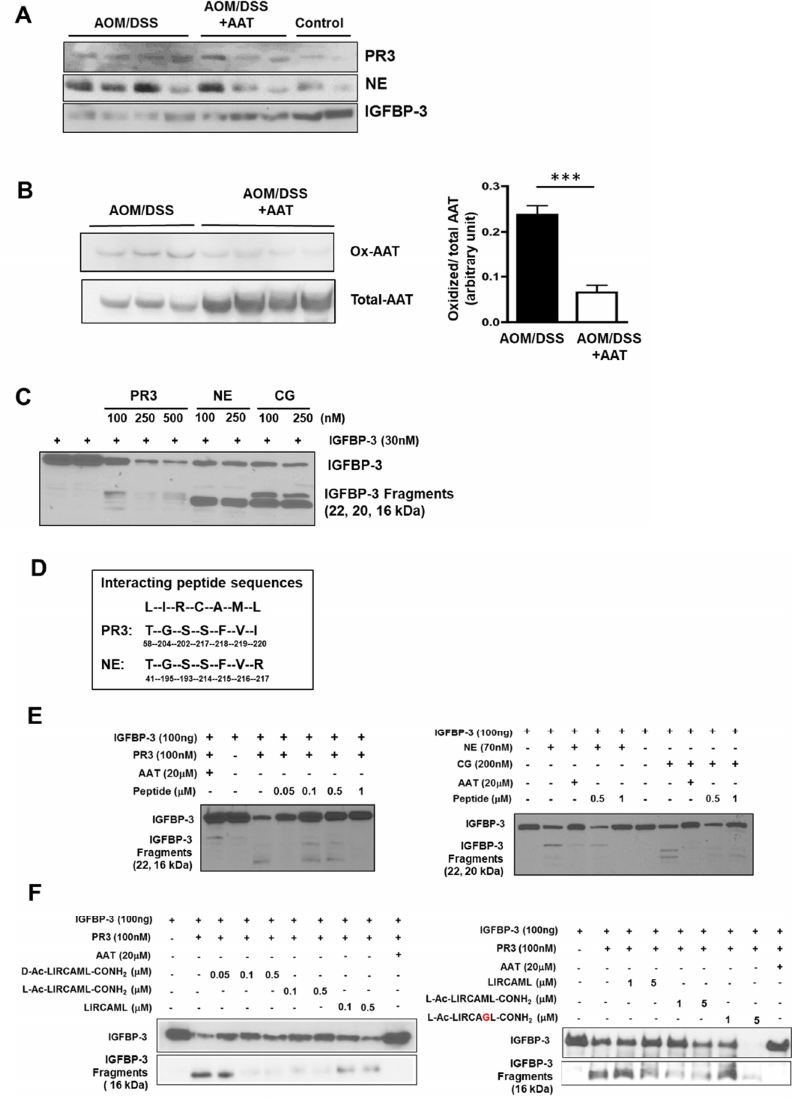
Figure 4. AAT suppresses increased serum neutrophil serine proteases PR3 and NE and subsequent IGFBP-3 proteolysis in AOM/DSS mice. ( A ) Representive WIB of sera from 4 AOM/DSS treated mice, 3 AOM/DSS+AAT treated mice and 2 control mice. AOM/DSS treated mice show increased PR3, NE and IGFBP-3 proteolysis in circulation whereas AAT administration results in significant inhibition of serum PR3, NE and increase of intact IGFBP-3 in circulation. ( B ) AAT administrated AOM/DSS mice show decreased level of oxidized-AAT but increased total AAT in circulation. ***, p < 0.001. ( C ) NSPs proteolyze IGFBP-3. Recombinant non-glycosylated human IGFBP-3 protein (30nM) was proteolyzed by treatment with 100, 250 and 500 nM of PR3, 100 and 250nM NE or CG for 20 min. at 37 °C. ( D – F ): AAT and AAT mimic inhibit NSP-induced IGFBP-3 proteolysis. Based upon the sequence identity among NSPs at a putative binding site of AAT and elafin, a 7 amino acid-long peptide (LIRCAML) was generated ( D ). IGFBP-3 proteolysis by PR-3 ( left figure) and NE, CG ( right figure) was inhibited by AAT (20 μ M) and different concentrations of an AAT mimic (0.05, 0.1, 0.5 and 1 μ M) ( E ). Few IGFBP-3 proteolytic fragments were detected in 20 μ M AAT treated or 1 μ M AAT mimic treated samples. Anti-protease activity of L- and D-form of N- and C-terminal modified AAT mimics ( left figure) ( F ). Nonfunctional mutant lost anti-protease activity ( right figure). The ratio of the oxidized over total AAT was decreased by up to 70% in AAT admin- istrated AOM/DSS mice. Observed reduction of the oxidized form of AAT, which lacks serine protease inhibitory activity [37,38], indicates that AAT administrated AOM/DSS mice would have increased functional AAT in circulation, thereby more potently inhibit- ing NSP-induced IGFBP-3 proteolysis. In order to confirm that the decreased level of IGFBP-3 in circulation in AOM/DSS mice is attributed to increased NSP-induced proteol- ysis, an in vitro proteolysis assay was performed using recombinant non-glycosylated hu- man IGFBP-3 protein. Recombinant IGFBP-3 (30nM) was proteolyzed by treatment with PR3, NE and CG in a dose-dependent manner (Figure 4C). Intact 28 kDa IGFBP-3 was gradually reduced by increased concentrations of NSPs, and concomitantly 16, 20 and 22 kDa IGFBP-3 proteolytic fragments were readily detected. It is our great interest to gener- ate and characterize the novel AAT mimicking peptide inhibitors of NSPs since current